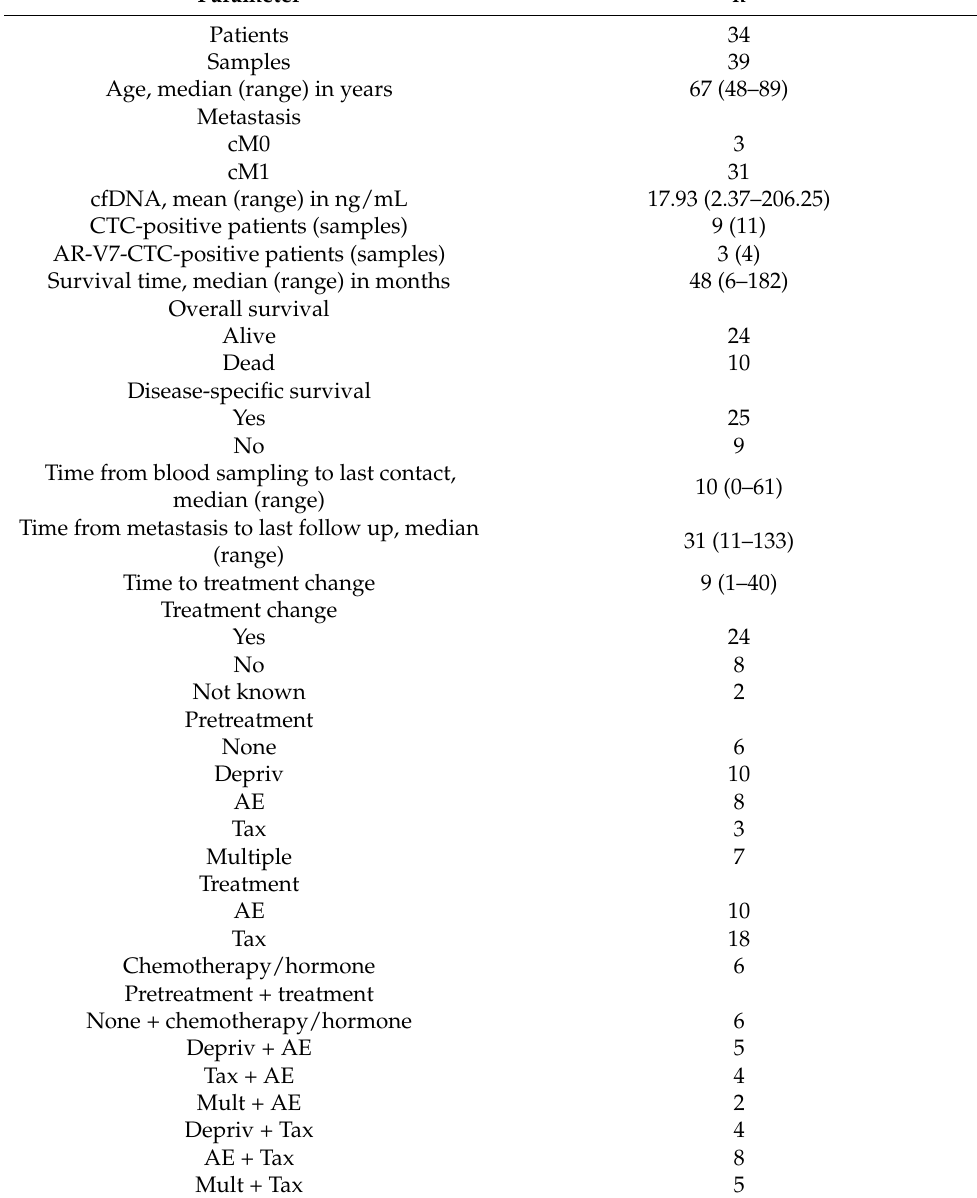
Table 1. Clinicopathological data, treatment data, and study